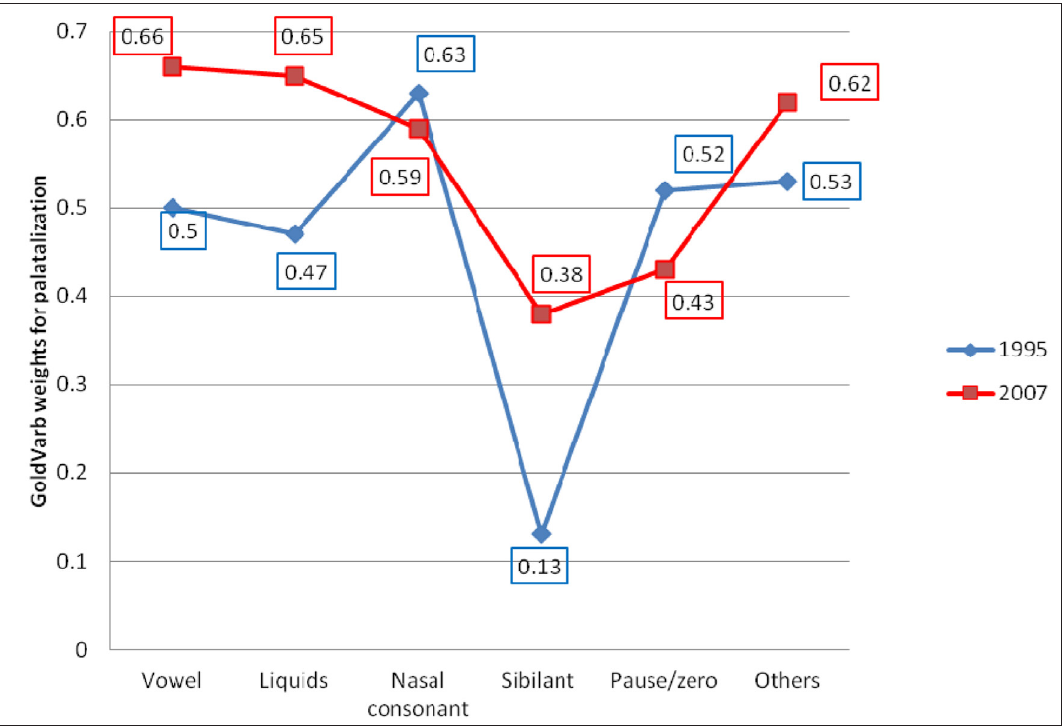
Figure 2: Probability of palatalization of /ti/, /di/ according to following phonological